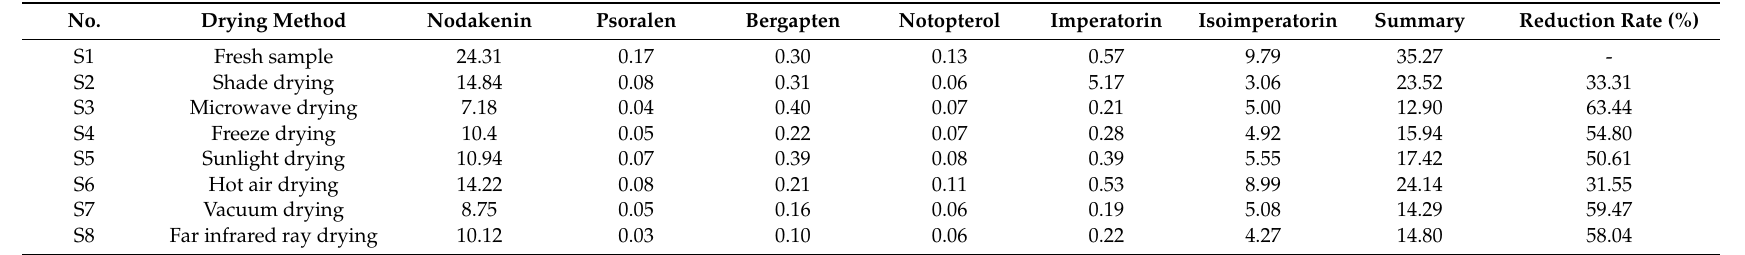
Table 2. The mean determination of six bioactive components in fresh N. franchetii , slices dried with di ff erent methods (mg / g, n =